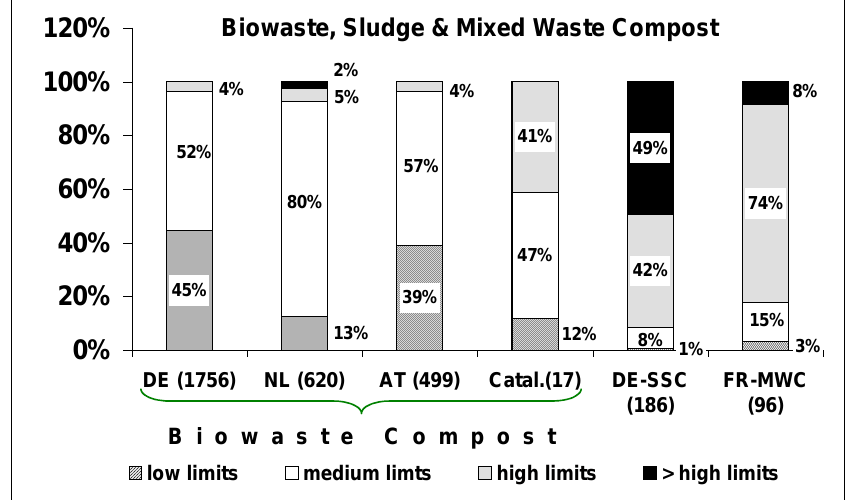
Figure 6: Percentage of BIOWASTE, SEWAGE SLUDGE (SSC) and MIXED WASTE (MWC) compost samples from DE, NL, AT, Catalonia (Catal.) and FR data sets within the assumed three limit concentration levels ( low, medium, high )